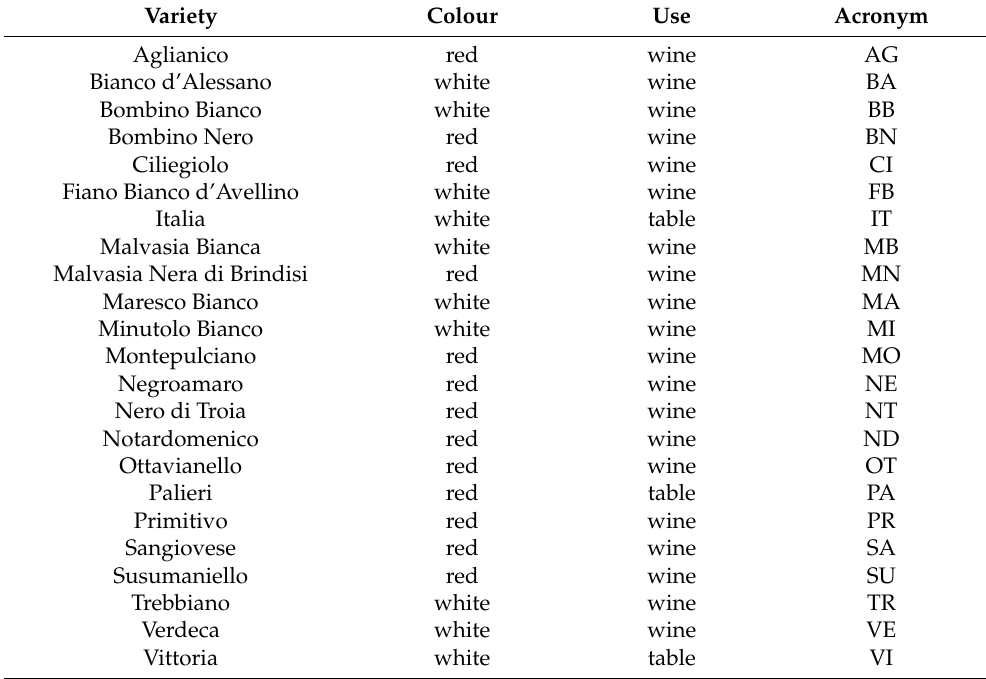
Table 1. The grapevine variety name, grape colour, usual use, and acronym used in the